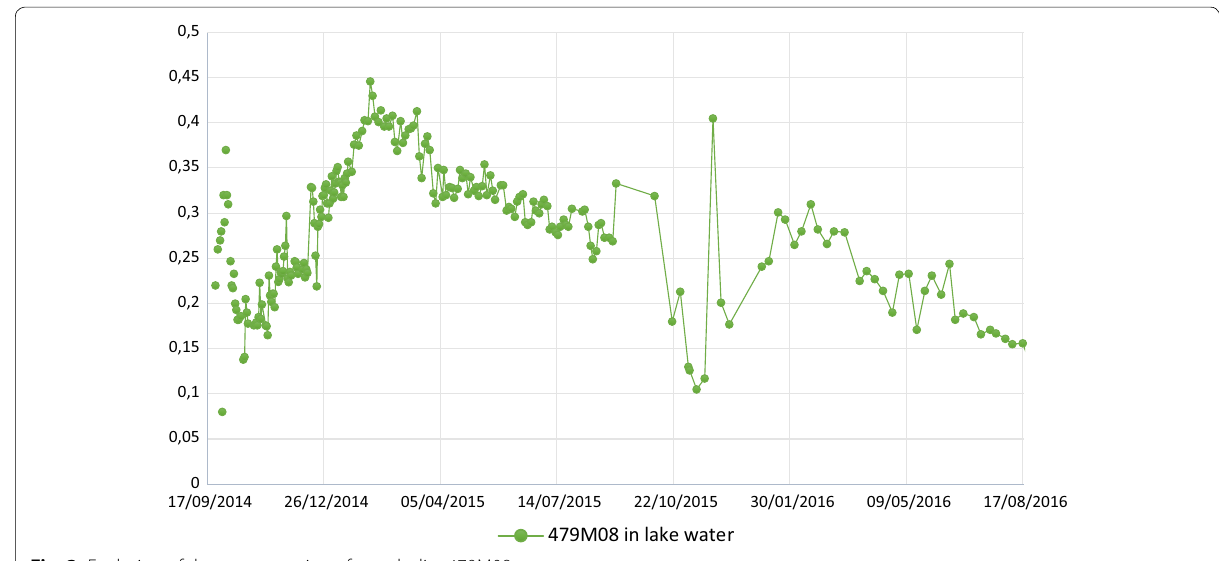
Fig. 3 Evolution of the concentration of metabolite